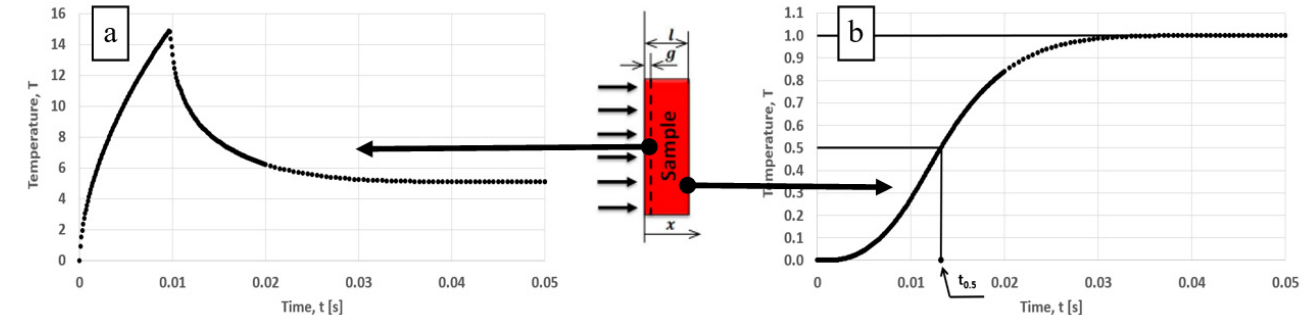
Figure 2. Heat transfer model for laser radiation coordinate system and initial conditions: ( a ) semi- transparent sample, ( b ) temperature rise on back surface and determination of half-life, where: g—effective sample thickness, x—Cartesian coordinate of a one-dimensional sample.